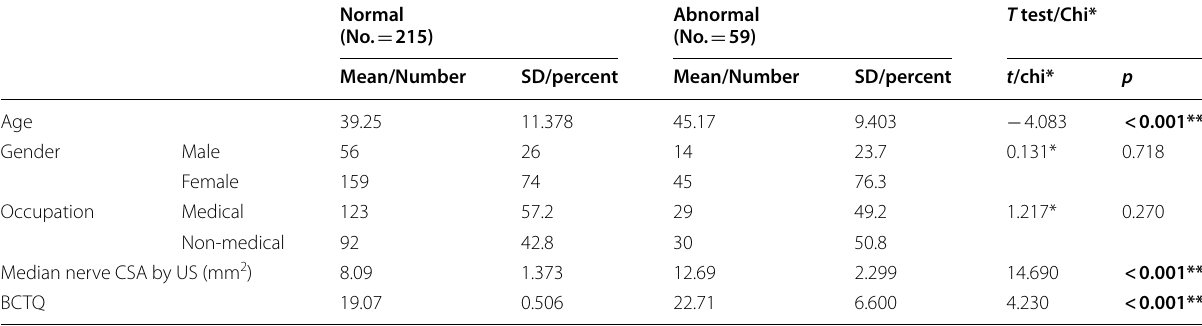
CSA cross sectional area, US ultrasound, BCTQ Boston carpal tunnel